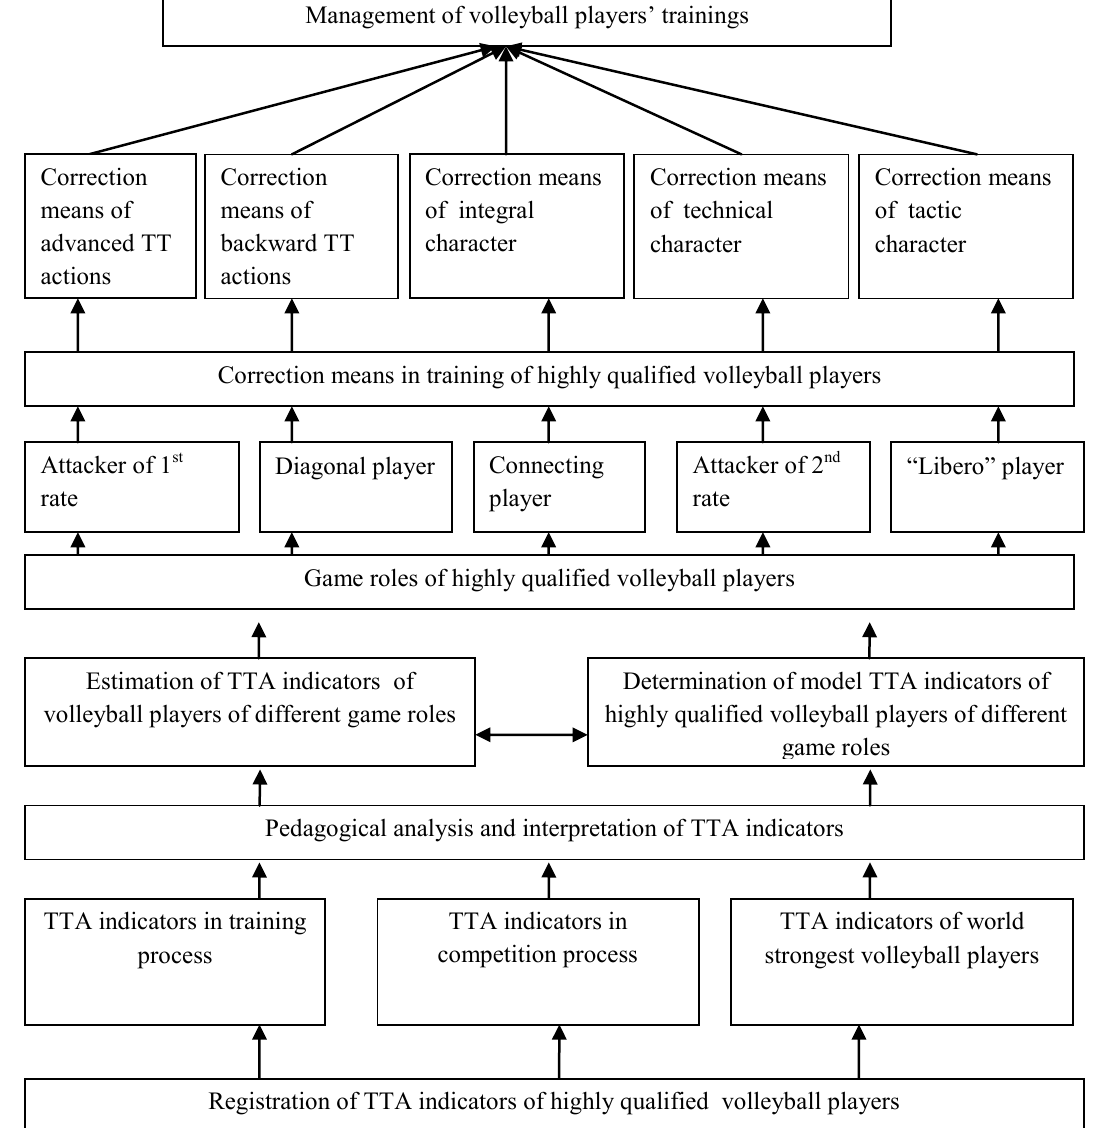
Fig. 1. Schema of training’s management on the base of appraisal and simulation of technical-tactic actions of highly qualified volleyball players of different game